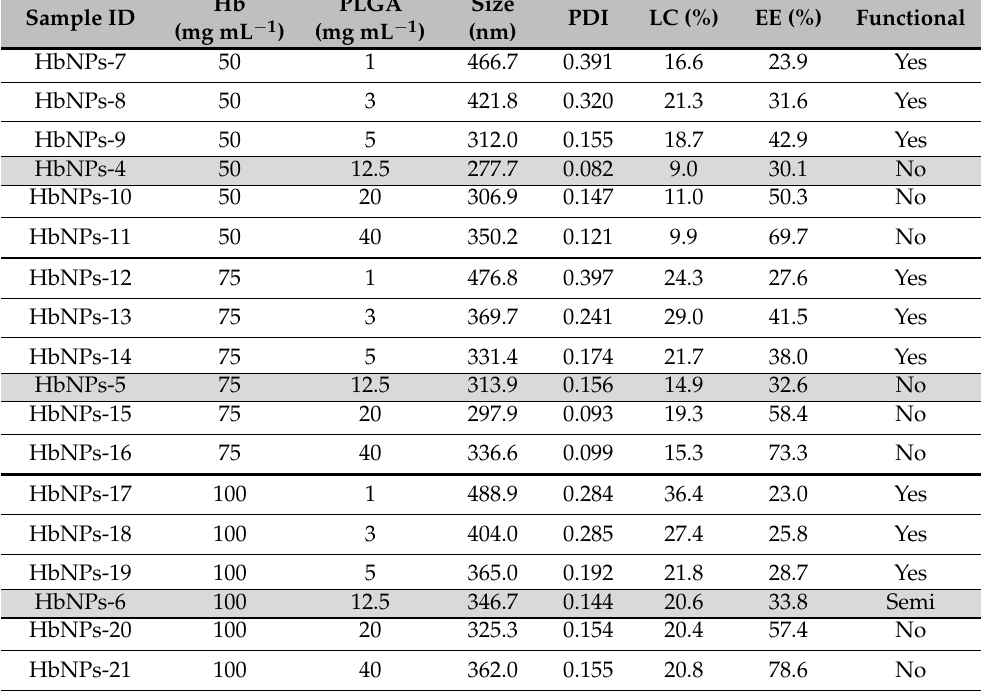
Table 3. Effects of the PLGA concentration on the size, polydispersity (PDI), loading content (LC), entrapment efficiency (EE) and functionality of the resulting HbNPs 1